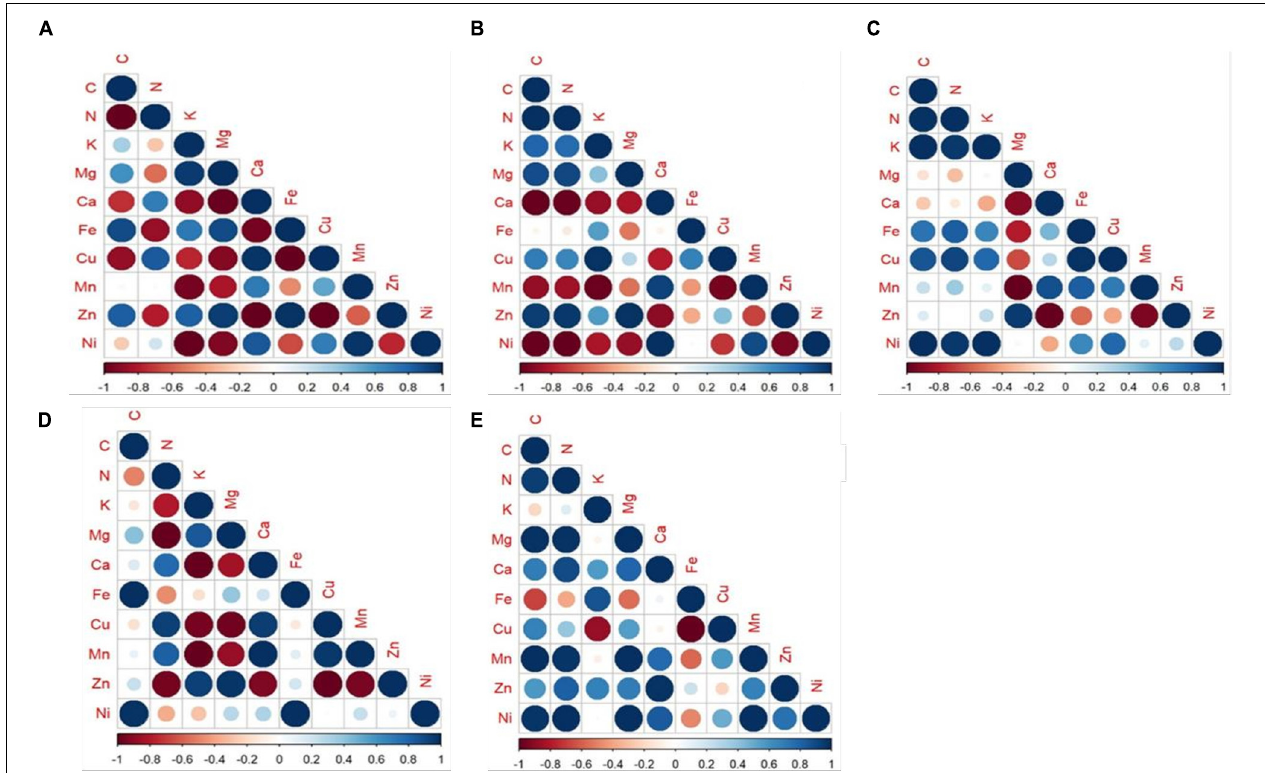
FIGURE 8 | Correlation between the nutrients under study in mature leaves subjected to different treatments of PM- (A) M. indica , (B) P. guajava , (C) F. religiosa , (D) A. indica , (E) D. sissoo . Blue-large dots showed maximum positive correlation and red-large dots showed maximum negative correlation with a gradient of color and size showing in between correlation